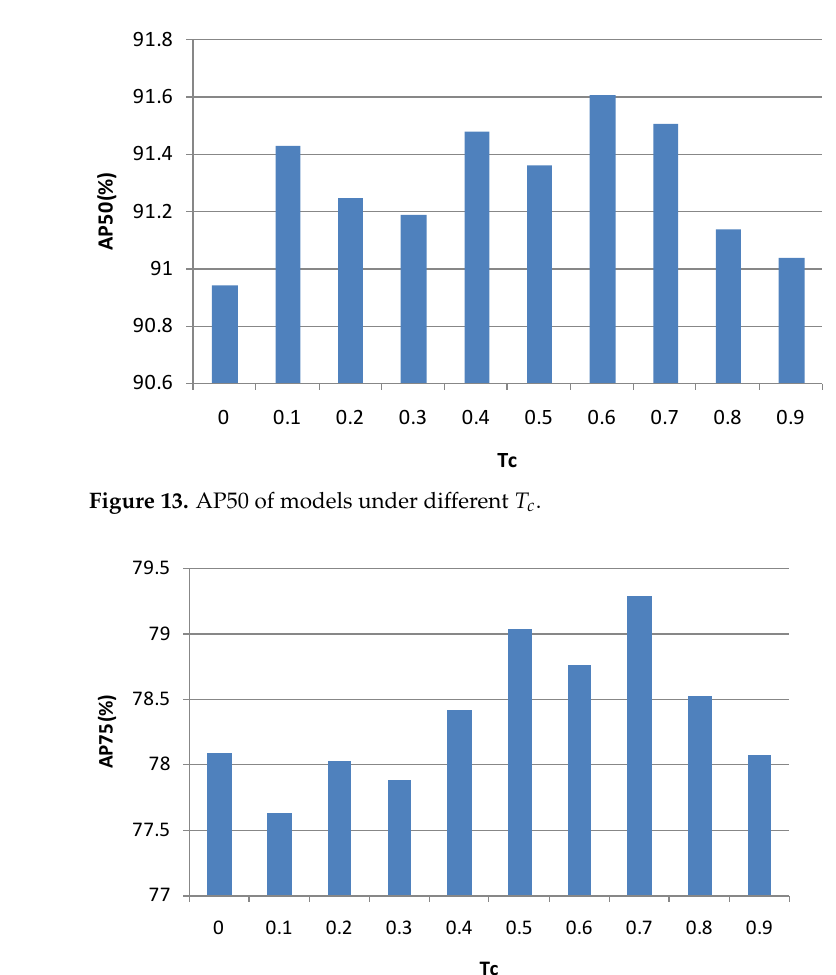
Figure 14. AP75 of models under different T c .